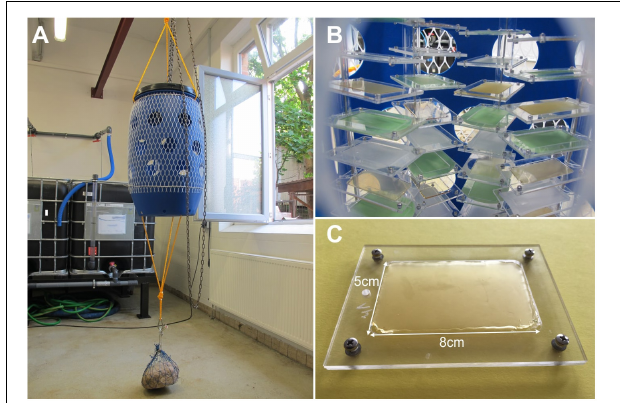
FIGURE 1 | Experimental setup. (A) A barrel was used to protect the samples situated inside. (B) The samples were put into sample holders that were mounted on PMMA pipes. (C) Typical sample used during the field experiment. The sample area was 5 × 8 cm.